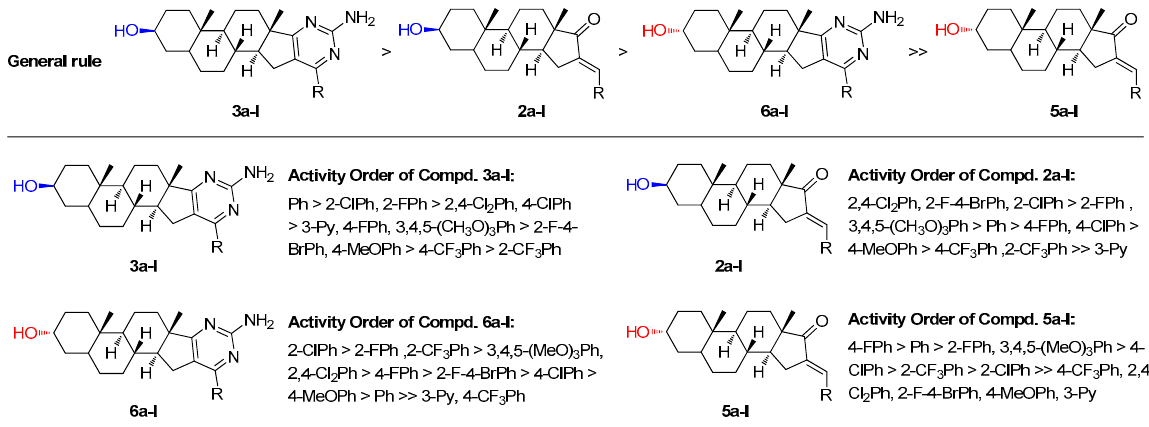
7 of 24 Table 2. Selectivity profiling of compound 3a against a panel of tyrosine kinases. Kinase